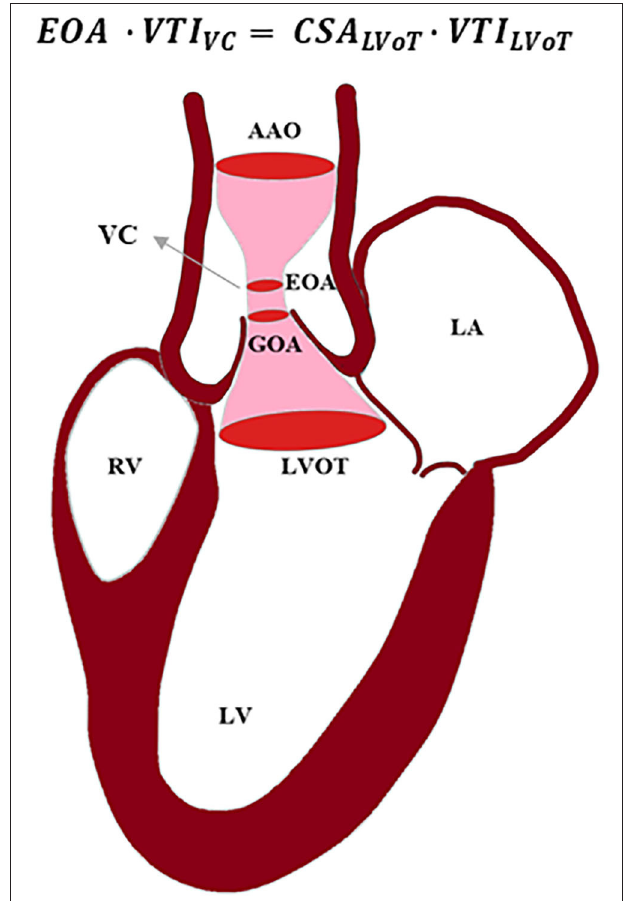
FIGURE 3 | Schematic of blood passing through a stenosed aortic valve. Using continuity equation, the effective orifice area (EOA) can be calculated based on velocity time integral (VTI) at vena contracta (VC), cross-sectional area (CSA) of left ventricle outflow tract (LVOT), and VTI at LVOT. AAO, ascending aorta; LA, left atrium; LV, left ventricle; RV, right ventricle; GOA, geometric orifice